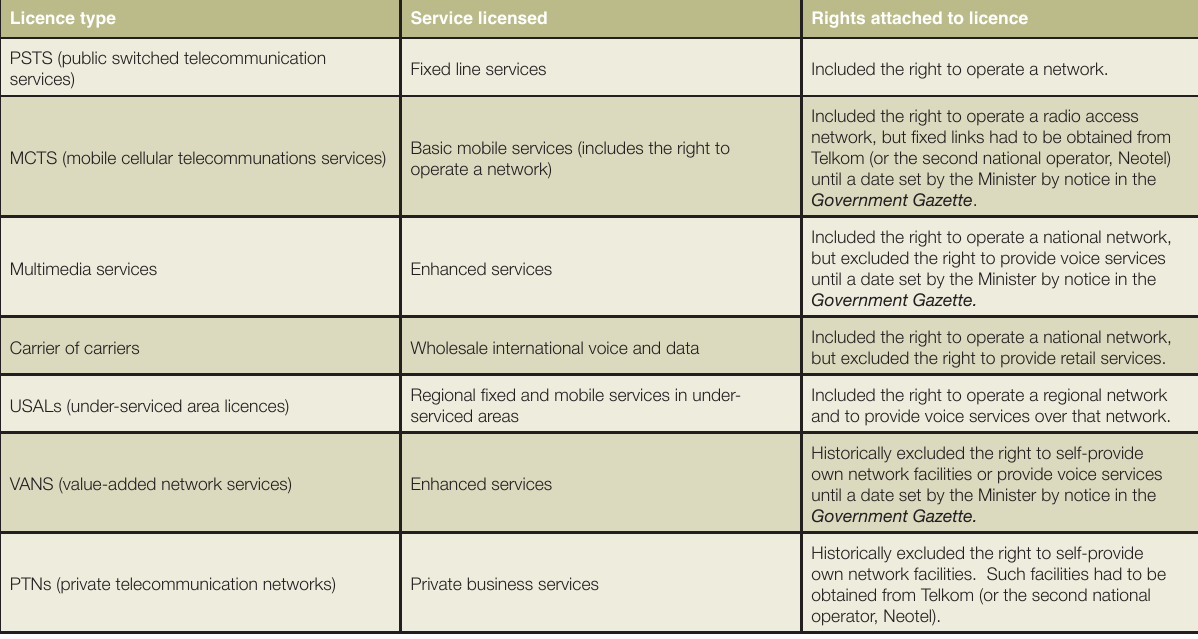
FIGURE 2: LICENCE CATEGORIES UNDER THE NOW REPEALED TELECOMMUNICATIONS ACT Licence type Service licensed Rights attached to licence Fixed line services Included the right to operate a network.